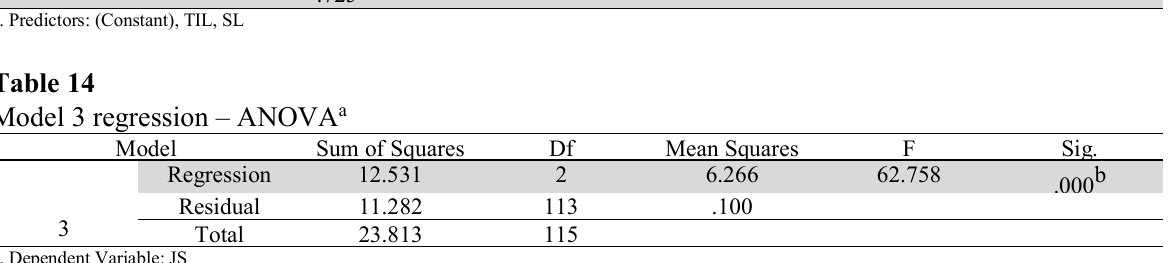
Model 3 Summary Model